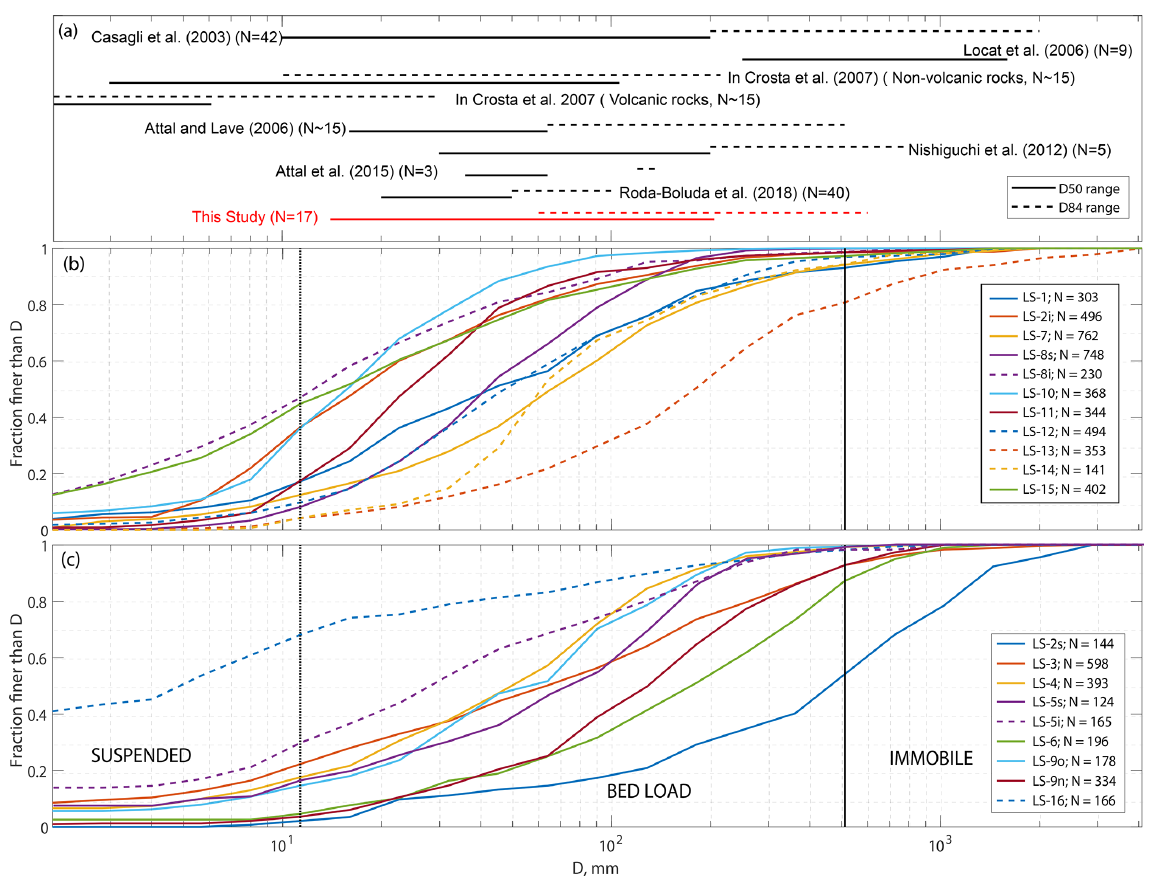
Figure 2. (a) Range of D 50 and D 84 for various studies, excluding the coarsest and finest distributions of each study. (b, c) Cumulative distribution function for the 17 sampled landslide deposits. Note that we show the surface and inner distributions for LS-5, LS-8 and LS-2; thus, 20 distributions are shown in total. For visibility, some lines are dashed and the distributions are shown in two panels. Vertical lines are the approximate boundary for grain transport by suspension and bed load, for a flood associated with a fluid shear stress of 220Pa (see Sect.